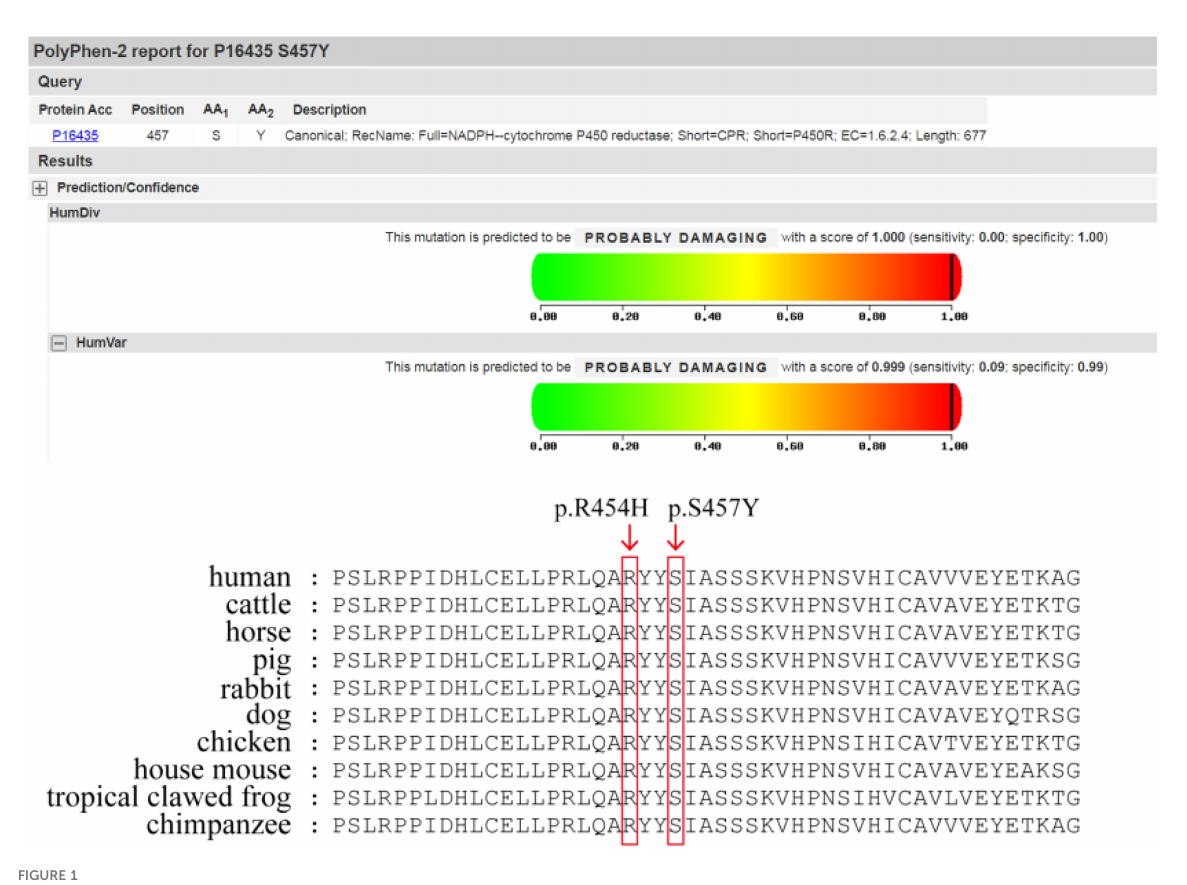
FIGURE 1 Polyphen2 prediction report & Prediction of protein